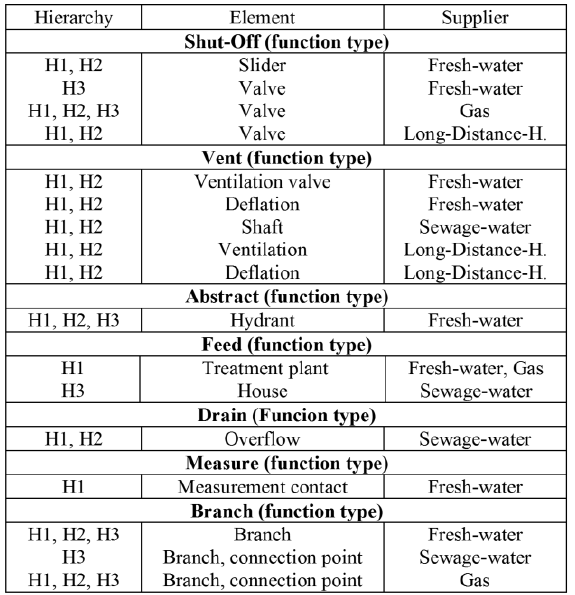
Figure 5. Highly cluttered visualization and orientation issue caused by an interrupted orientation chain